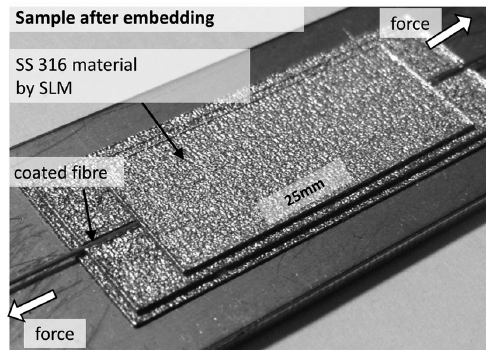
Figure 22. Image of steel sample with embedded FBG for strain testing [86].